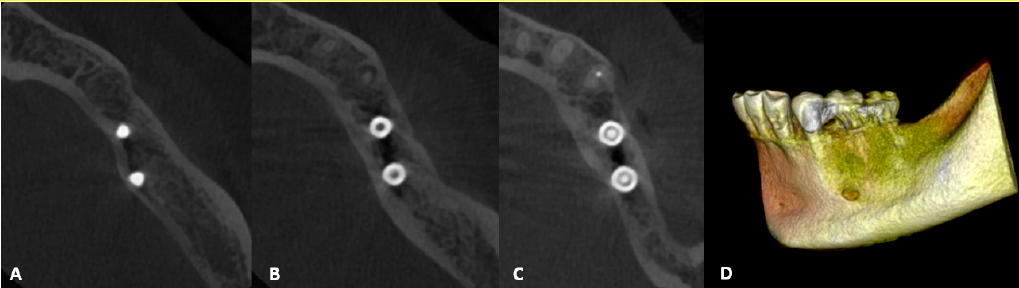
Figure7. CBCTfollow-upat37months. ( A – C )Axialviewfrombottomupwards. ( D )Three-dimensional rendering (OsiriX) based on CBCT from postoperative check-up at 37 months after regenerative